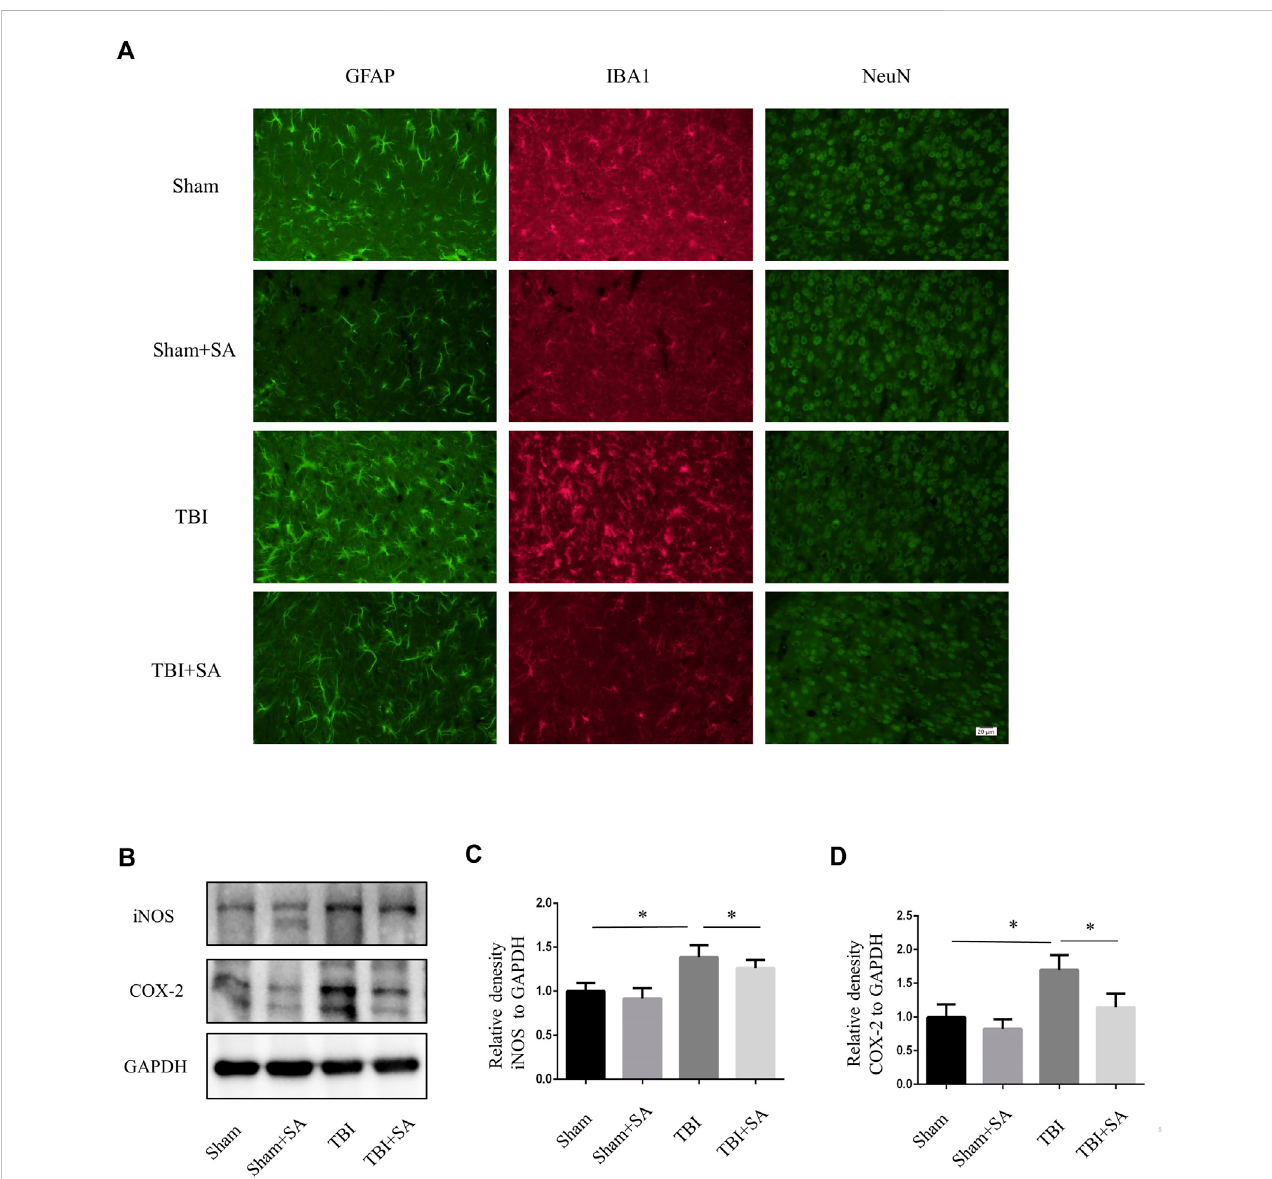
FIGURE 5 SAinhibitsactivationofglialandexpressionofin fl ammatoryproteinsincorticaltissueTBImice. (A) MiceweresubjectedtoTBIandreceivedSA(1 mg/kg) andvehicleonceadayforsevenconsecutivedays.ThebrainswerecutintobrainslicesandstainedbyantibodyGFAP,IBA1andNeuN. (B) Corticaltissueswere taken from TBI model mouse animals, the protein levels of iNOS, COX-2 and GAPDH were detected using western blot. (C – D) Statistical plots of iNOS and COX-2 in fl ammatory protein expression. Date are presented as mean ± SD, * p < 0.05, ** p < 0.01, n = 3 per group. Scale bar, 20 µm. Coronal